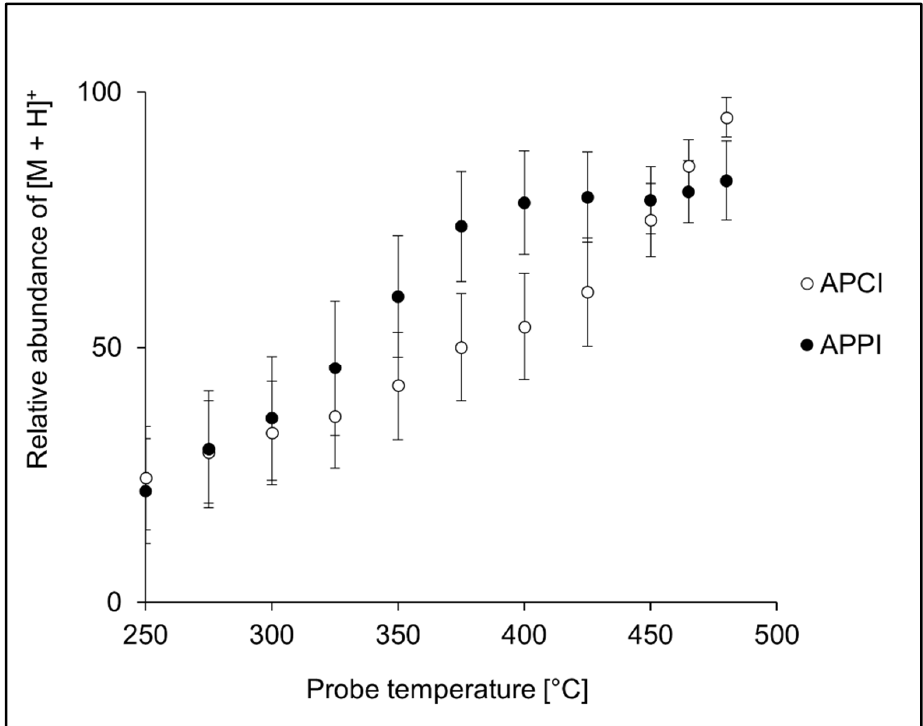
Figure 2. Effect of the probe temperature on the averaged relative intensities of [M + H] + calculated for all 20 peptide standards in APCI and APPI. The error bars represent the standard errors of the mean.